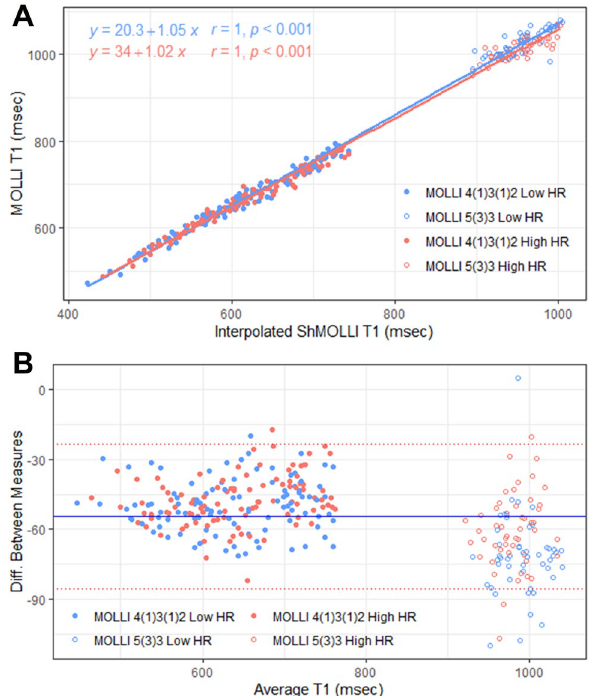
Figure 6. Relationship between T1-mapping variants. Linear fit for T1-mapping variants on native rest, stress, and post-contrast T1 (A) and analysis of differences plot comparing the results from MOLLI variants against all interpolated ShMOLLI values (B). The blue solid line (B) indicates the mean difference between ShMOLLI and MOLLI. The red dotted lines (B) indicate the 95% limit of agreement for all pooled MOLLI compared to ShMOLLI. Post-contrast T1 values are measured using the MOLLI 4(1)3(1)2 sequence with Low HR and High HR sub-variants; stress T1 values are measured using the MOLLI 5(3)3 sequence and Low HR and High HR